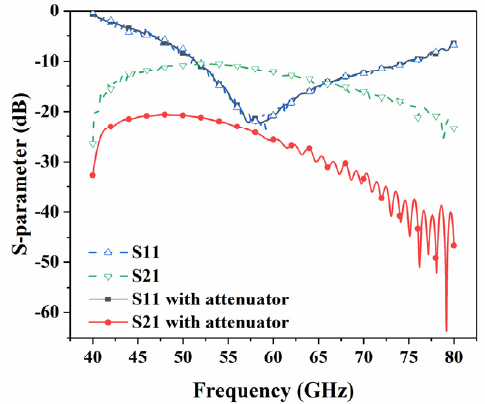
Figure 8. The S–parameters of the MDSRL-RSML SWS. Figure 8. The S – parameters of the MDSRL-RSML SWS.